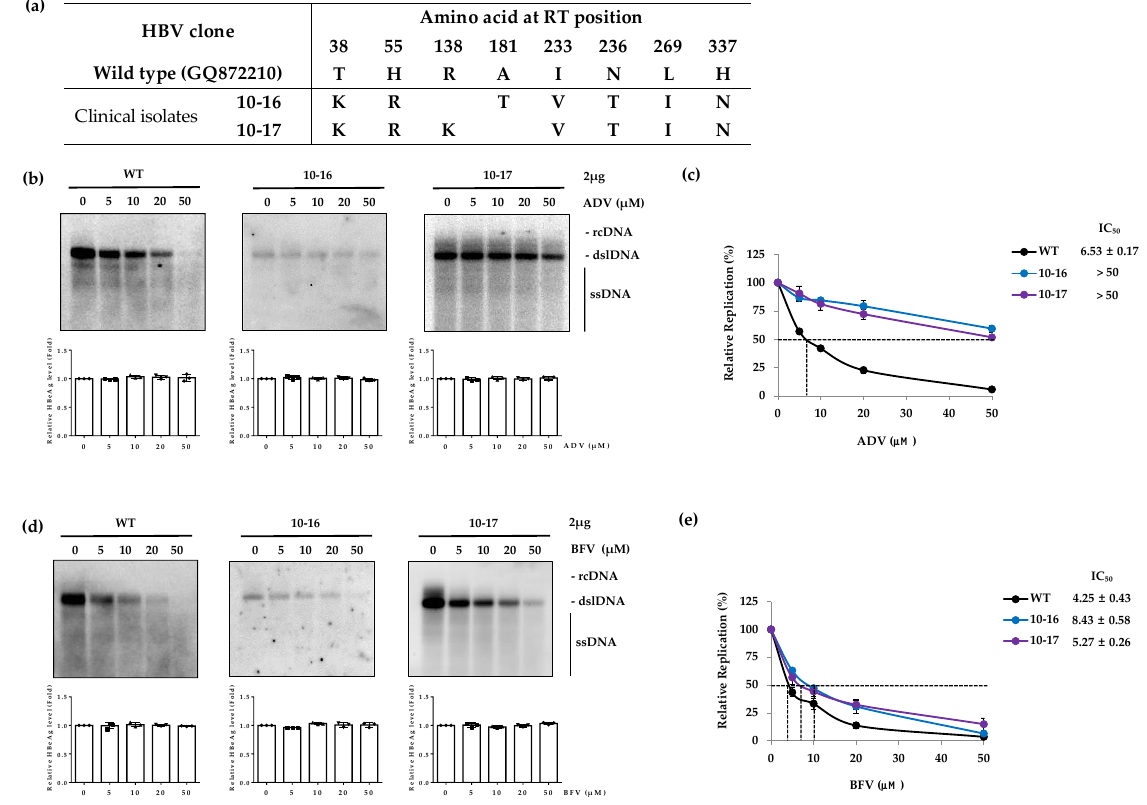
Figure 2. In vitro BFV susceptibility of ADV-resistant patient-derived clones. ( a ) Representative sequence of ADV-resistant clones derived from patients. ( b , top) The ADV-resistant clinical isolates were transfected into the Huh7 cells, followed by administration with ADV for 4 days. The susceptibility to ADV was measured by Southern blot. ( c ) The IC 50 values for ADV-resistant clones were compared to that of WT. ( d , top panels) After treatment with BFV, the replication of ADV-resistant HBV RT mutants was analyzed by Southern blot. ( e ) The IC 50 values of BFV for WT and mutant HBV clones were quantified and compared. ( b , d , bottom panels) HBeAg in culture supernatant was measured by ELISA. The data were obtained from at least three independent experiments (mean ± SD). BFV, besifovir; ADV, adefovir.